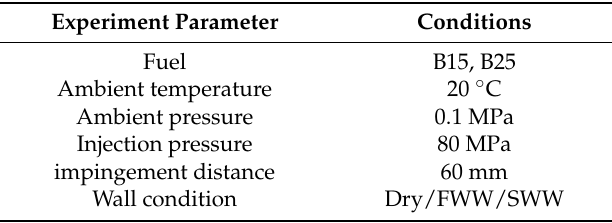
Table 3. Experimental conditions.